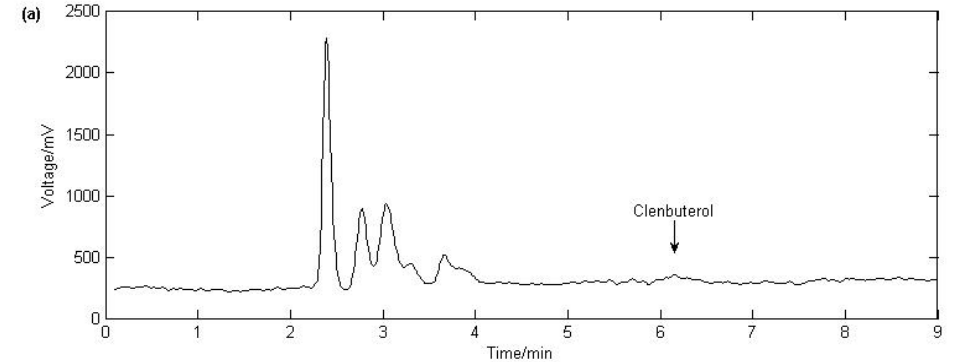
Figure 2. Chromatogram of urine spiked with clenbuterol at 0.025 ng/mL. ( a ) Full length of the chromatogram. ( b ) Especially enlarged chromatogram of clenbuterol. ( c ) The peak of clenbuterol obtained by ASSR with b =